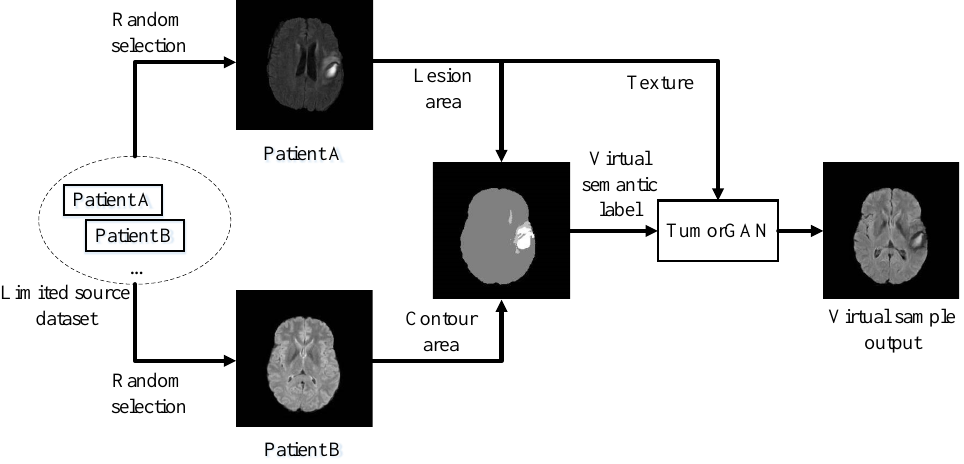
Figure 1. An overview of TumorGAN-based medical image